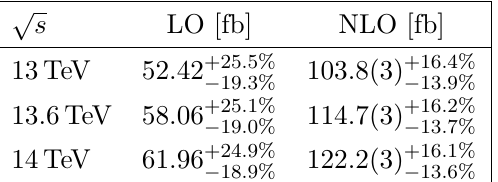
√ s = 14 TeV m OS t = 173 . 21 GeV